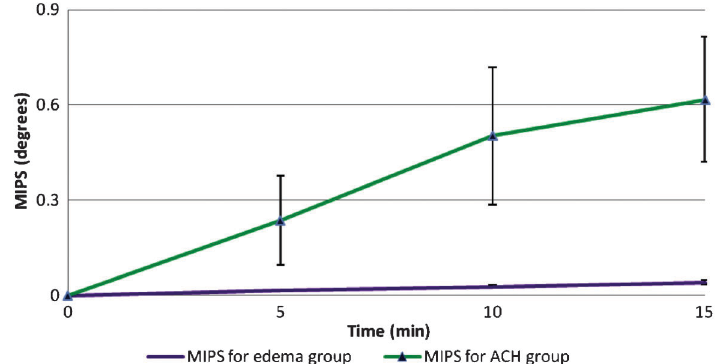
Figure 7. Magnetic induction phase shift (MIPS) of the acute cerebral hemorrhage (ACH) group compared with the control group. The average value of MIPS of 6 rabbits from the ACH group increased to 0.6173±0.1976 degrees with the injection volume from 0 to 3 mL. MIPS changed from 0 to 0.041±0.0073 degrees in the control